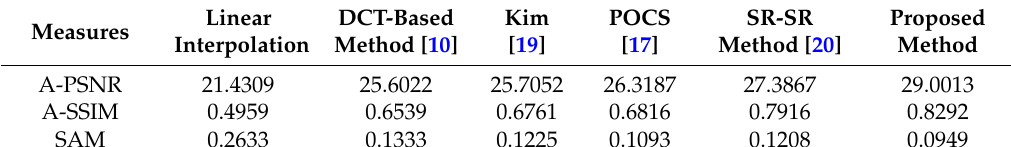
Table 2. Comparison results of A-PSNR, A-SSIM and SAM for the PaviaC dataset.